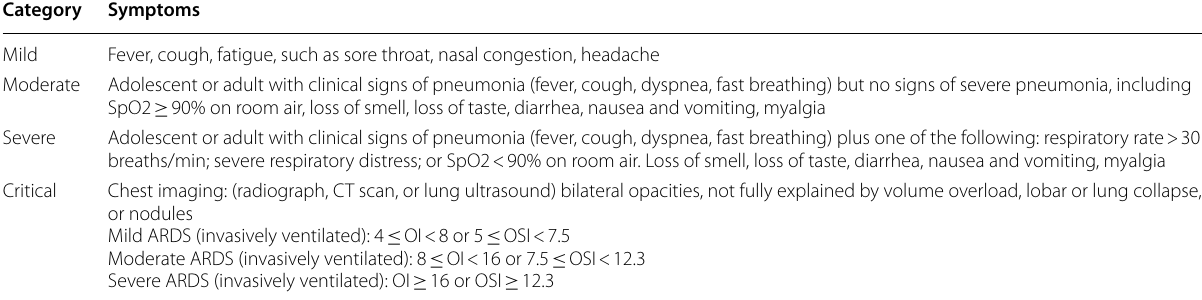
ARDS Acute respiratory disease syndrome, CT Computerized tomography, OSI Oxygen Saturation Index, OI Oxygenation Index